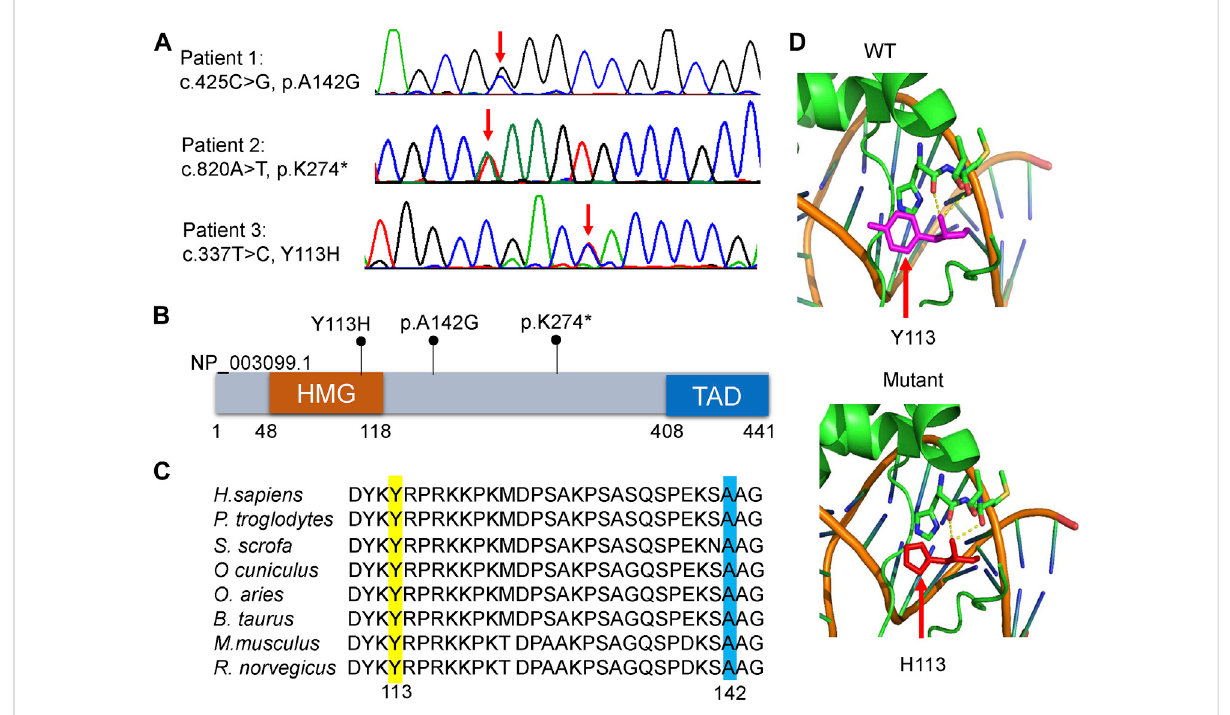
FIGURE 2 Molecular characteristics of the patients. (A) Sanger sequencing revealed that each patient harbored a heterozygous variant in SOX11 gene (NM_003108.4). Red arrowsindicate the variant base. (B) Distribution schematic of thethree variants of SOX11 gene identi fi edin this study. Of them, the variant of Y113H localize to the high-mobility group (HMG) domain. TAD, transactivating domain. (C) Inter-species amino acid sequence alignment to show the missense variants of Y113H (yellow) and A142G (blue) within a highly conserved region of the protein. (D) Solved and predicted three-dimensional models of WT and mutant (Y113H) SOX11. The crystal structure was simulated using the mouse Sox4 HMG